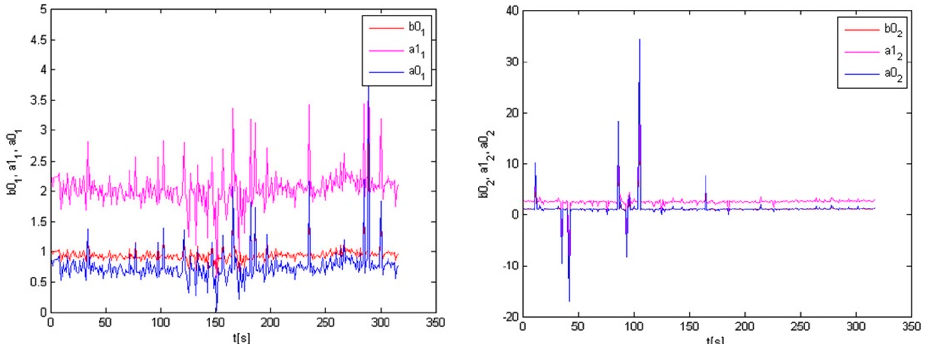
Figure 12. Output of control . Figure 13. Controllers parameters during simulation—1st ( left ), 2nd ( right ). 6. Conclusions This paper presents the new method of identification named as pre-identification on the theoretical level and subsequently verified it by simulations and in the real-time ex- periments at Coupled Drives model in the laboratory. The results confirm that the method can be successfully used and future work will focus on the verification of this method on